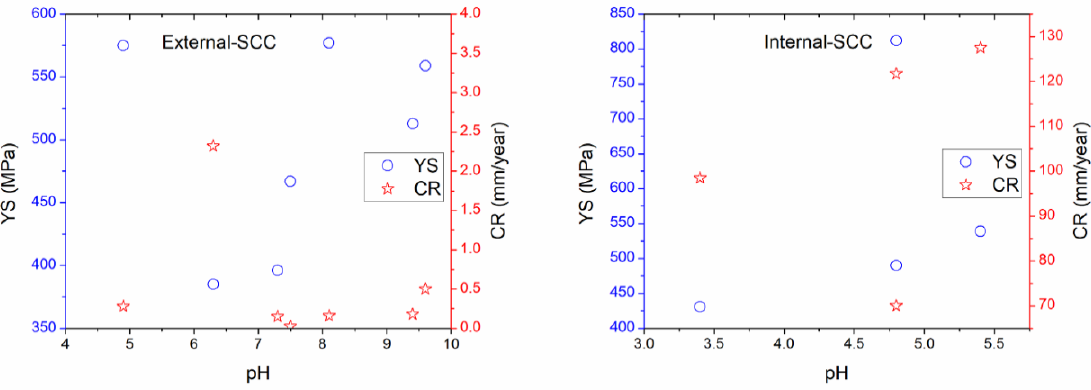
Figure 6. Comparison of the E-SCC and I-SCC behavior based on mechanical–electrochemical– physicochemical properties.